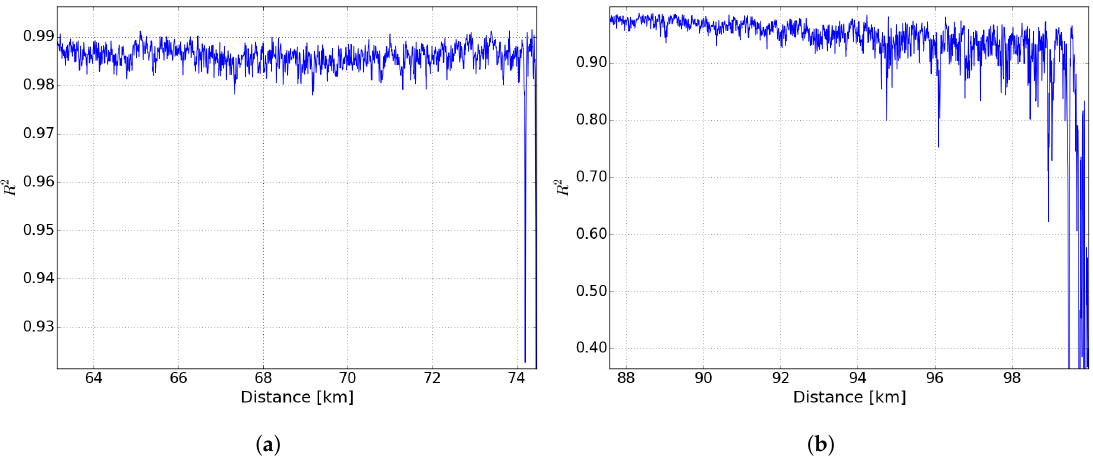
Figure 8. Coefficient of determination R 2 , calculated by comparison of fitting with Lorentzian function and measurement data over distance for ( a ) 75 km and ( b ) 100-km sensing fiber.